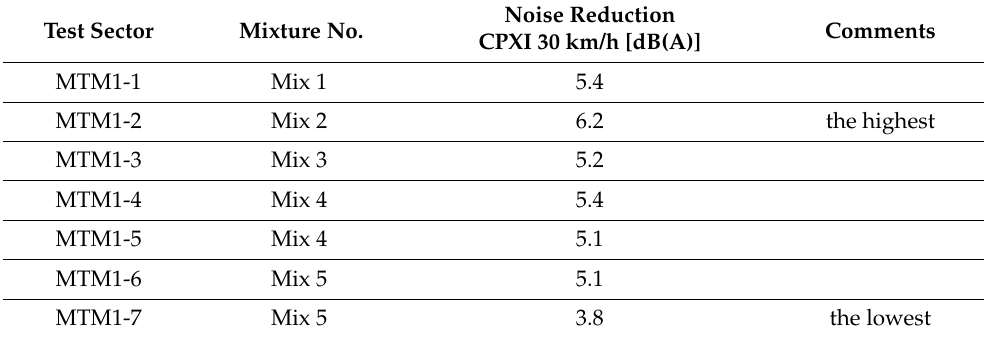
Table 6. Noise reduction of prototype poroelastic mixtures obtained on the first short test section.